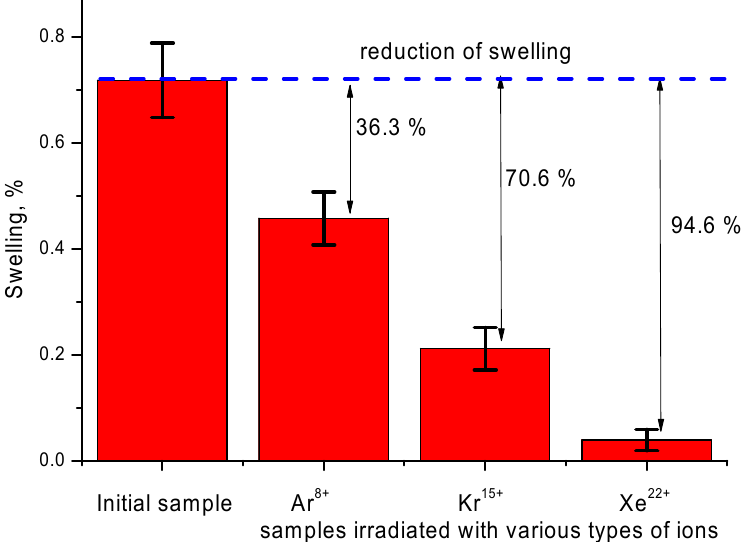
Figure 3. Results of the crystal-lattice helium swelling.